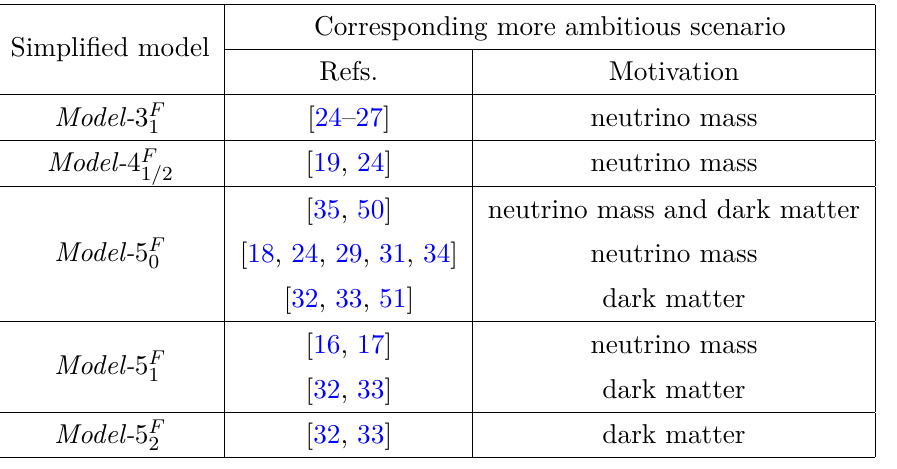
Table 3 . Some simplified models and corresponding more ambitious scenarios studied in the